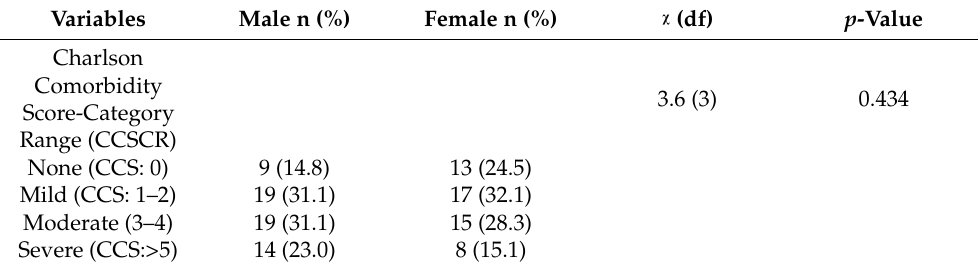
Table 7. Patients’ Charlson Comorbidity Score-Category Range (N = 114). Table 6. Patients’ Charlson Comorbidity Index Score CCIS measurement (N = 114).